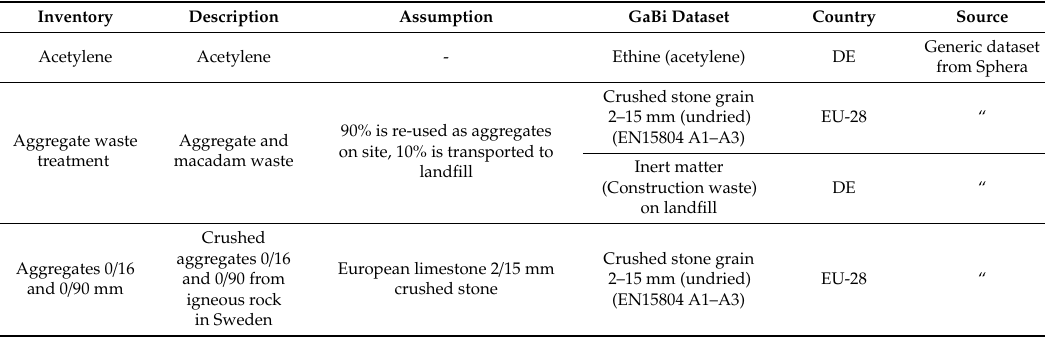
Table A1. Assignments of inputs and outputs to LCIs from the GaBi database for the